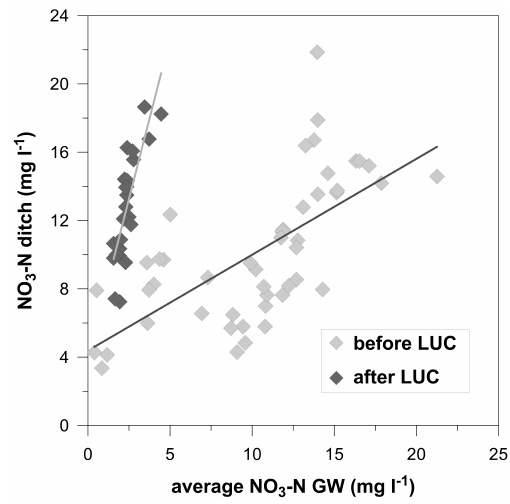
Figure 7. Relationship between the average nitrate–nitrogen (NO 3 – N) concentrations in the dip wells and the NO 3 –N concentrations in the ditch before and after land use change (LUC). NO 3 –N concen- trations of the ditch are 10-day means starting on the date of dip well